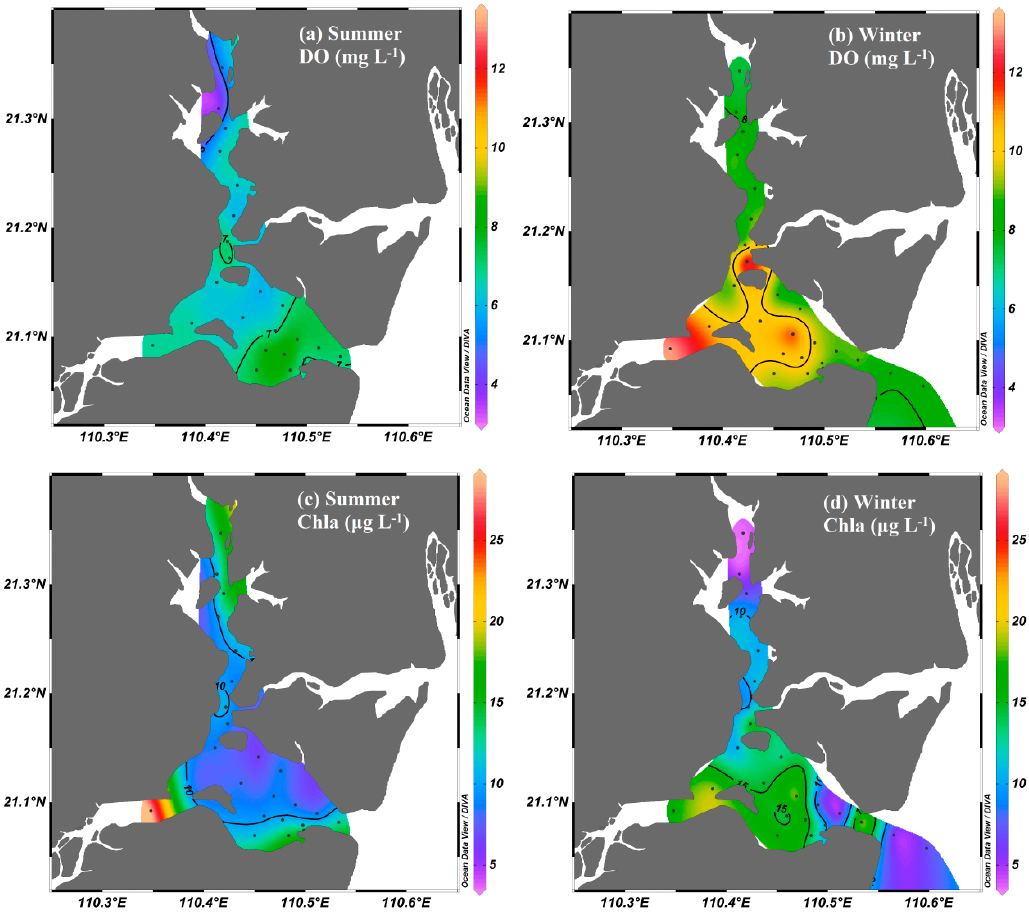
Figure 3. Spatial and seasonal distributions of dissolved oxygen (DO) and chlorophyll a (Chl a ) in Zhanjiang Bay.